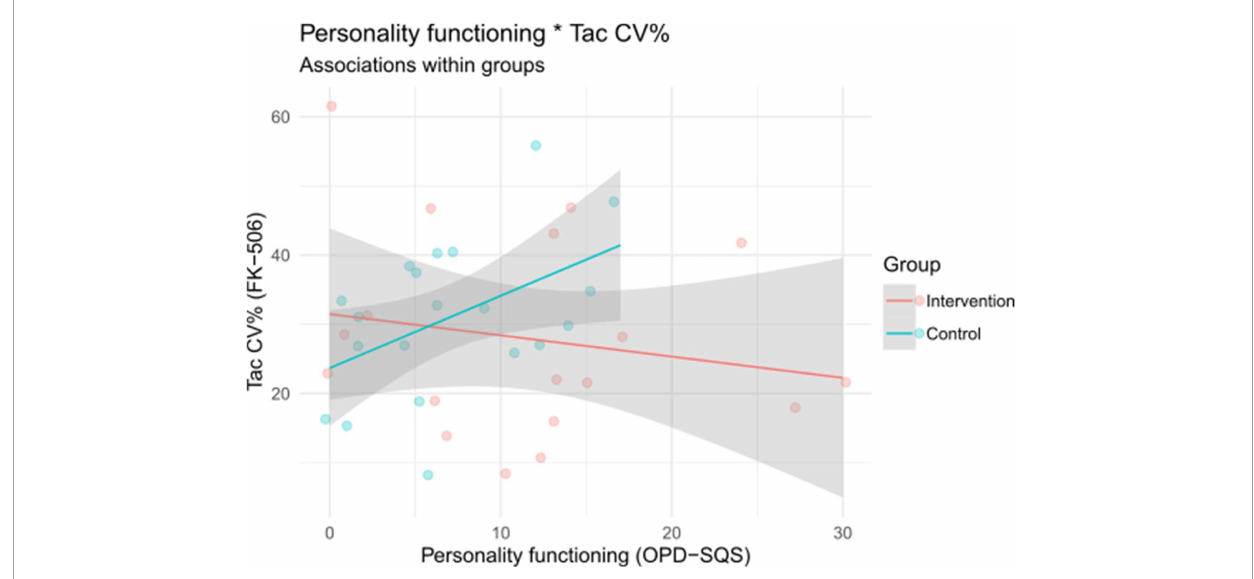
FIGURE5 Associations between personality functioning and TAC coefficient of variation (CV%) within groups. OPD-SQS, Operationalized Psychodynamic Diagnosis Structure Questionnaire Short